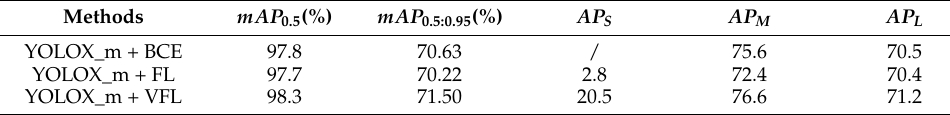
Table 4. Performance comparison of different confidence loss functions.